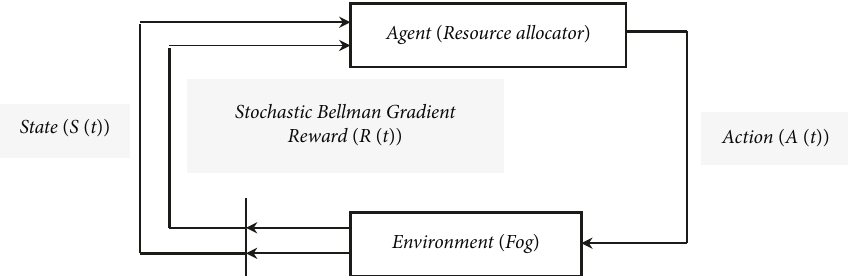
Figure 3: Block diagram of Stochastic Gradient and Deep Reinforcement Learning-based Resource Allocation